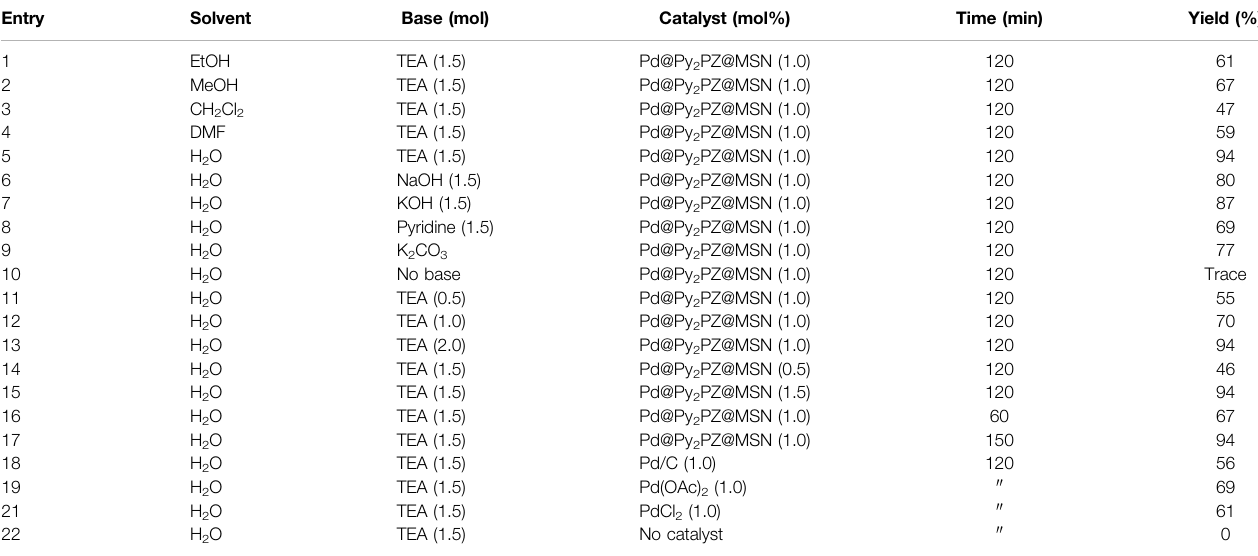
TABLE 2 | Optimization of the reaction of styrene and phenyl bromide in the presence of the Pd@Py 2 PZ@MSN